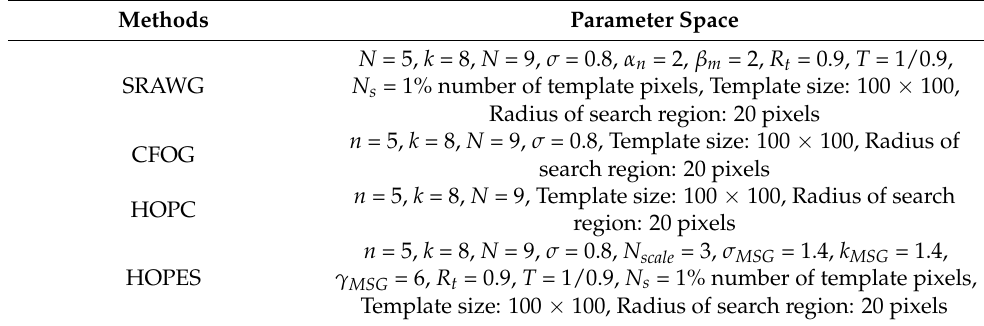
Table 2. The experimental parameter settings of each